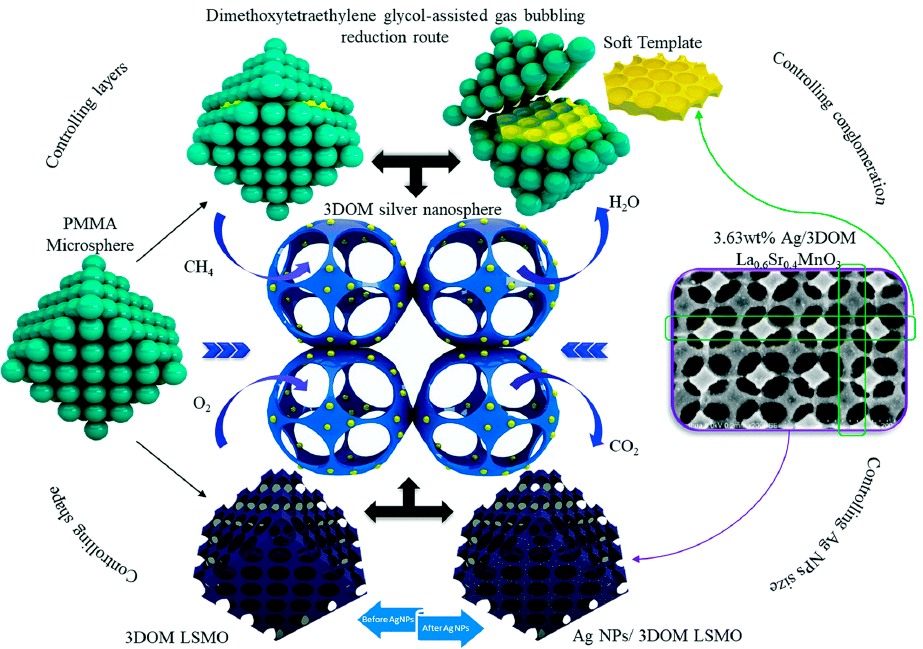
Figure 3. Schematic illustration of loading Ag NPs on 3DOM LSMO. Reprinted with permission from Ref. [47]. Copyright 2013, copyright Royal Society of Chemistry.